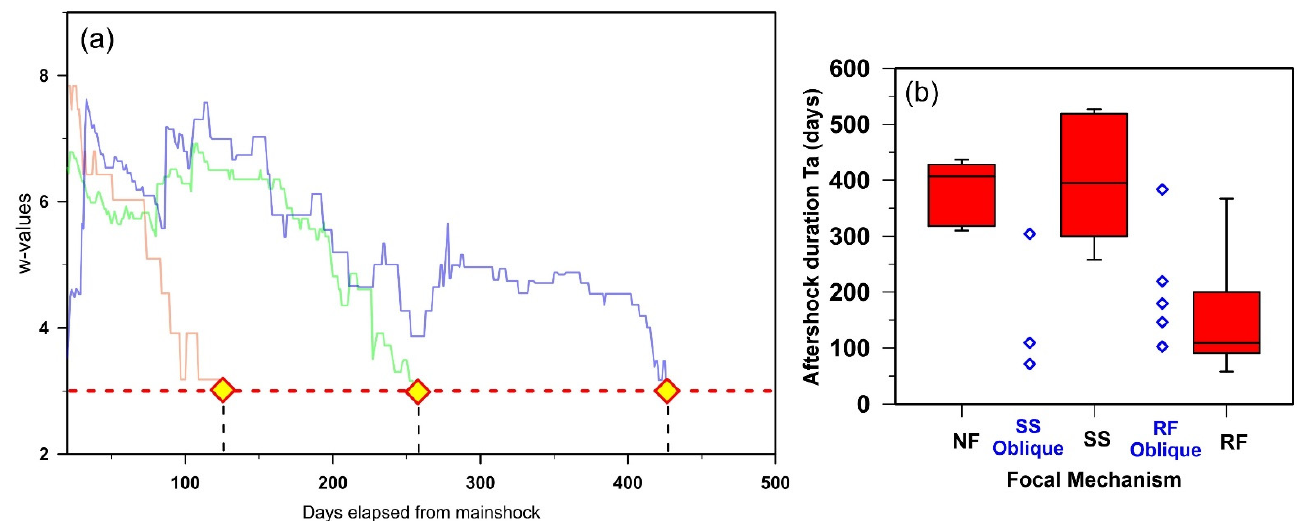
Figure 6. ( a ) Examples of the methodology applied to estimate T a for a strike-slip (green), normal (blue) and reverse (orange) faulting mainshock. The dashed horizontal line denotes the threshold value of w t = 3 corresponding to 99.9% significance level. ( b ) Results for all seismic sequences are presented classified by faulting style (NF: Normal Faulting; SS: Strike-Slip; RF: Reverse Faulting; SS Oblique, RF Oblique).